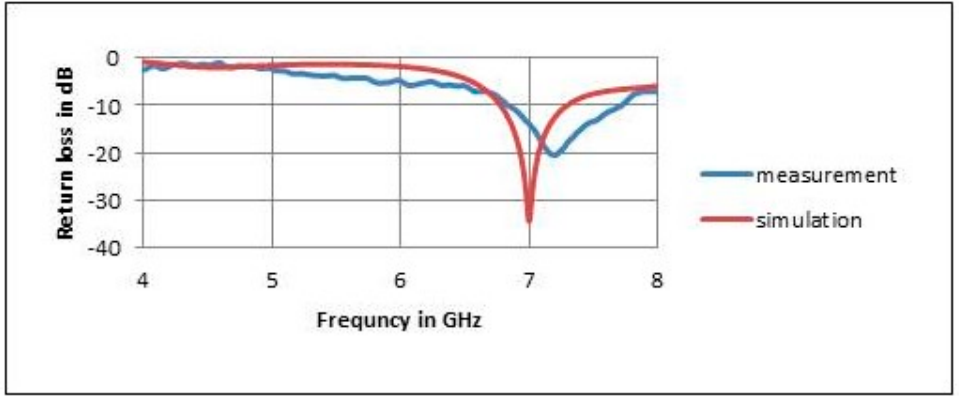
Figure 7. The comparison of simulated and measured return loss of antenna B.